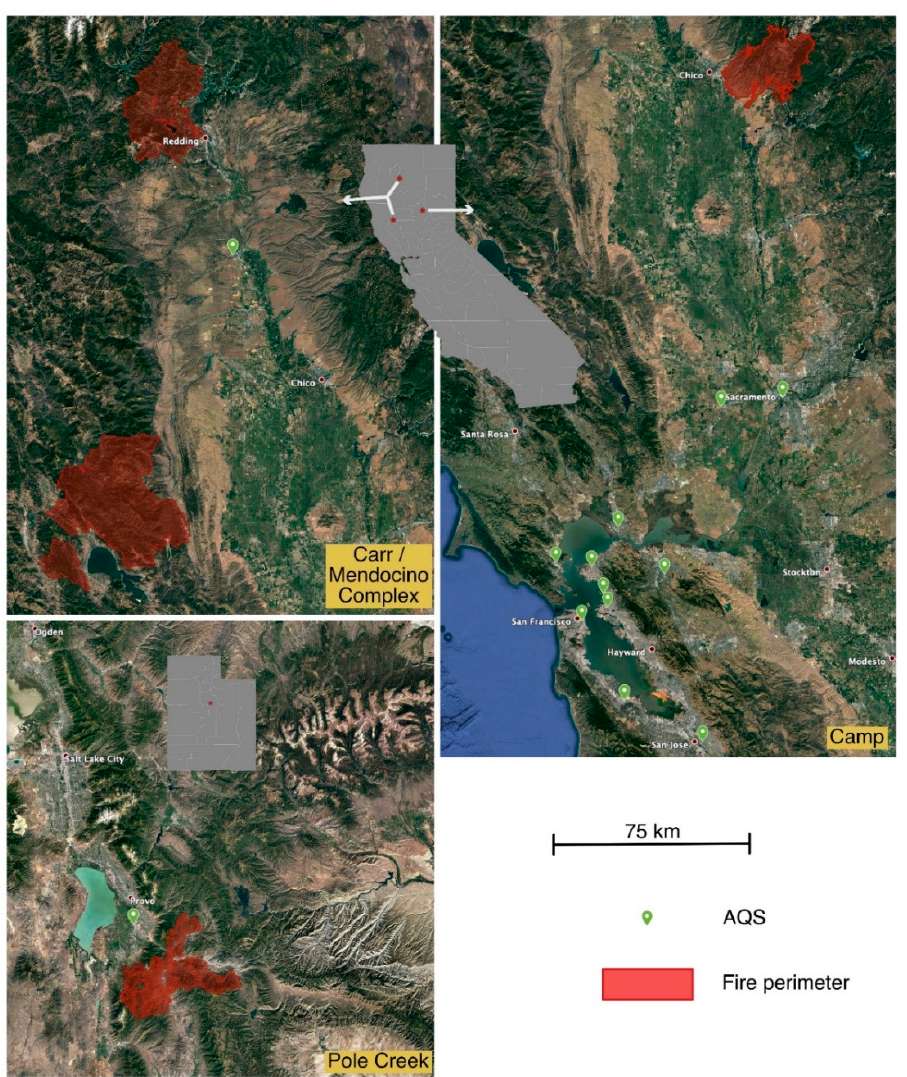
Figure 1. Areas burned (red) and locations of air quality monitoring stations (green dots) reporting hourly PM 2.5 that also had nearby PA-II monitors. Gray images are the states of California (top) and Utah (bottom) and red dots show the locations of the detailed maps with the states. The 75 km scale marker applies to all three detailed images. Satellite images were obtained via Google Earth. Fire extent data from https: // fsapps.nwcg.gov /